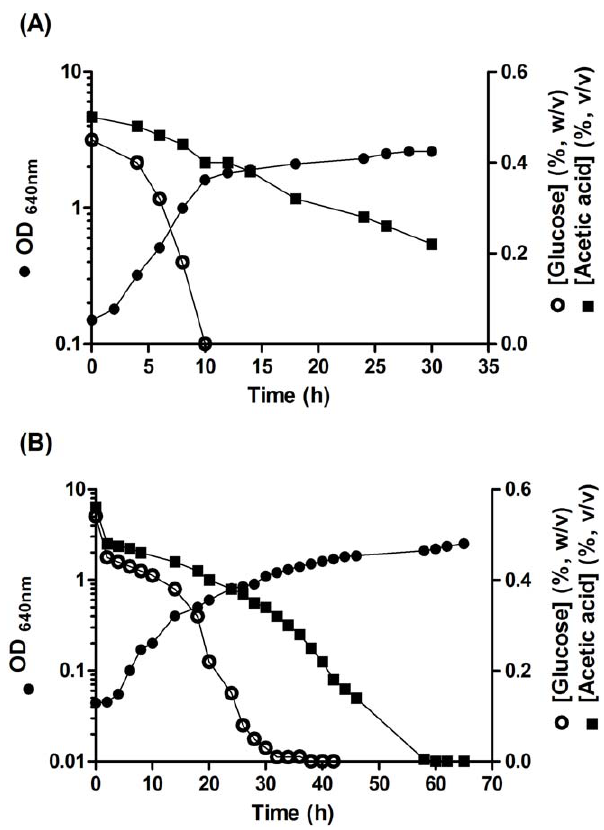
Figure 1. Growth of Z.bailii ISA 1307 at pH 5.0 (A) and pH 3.0 (B) in a medium containing glucose (0.5%, w/v) and acetic acid (0.5%, v/v).